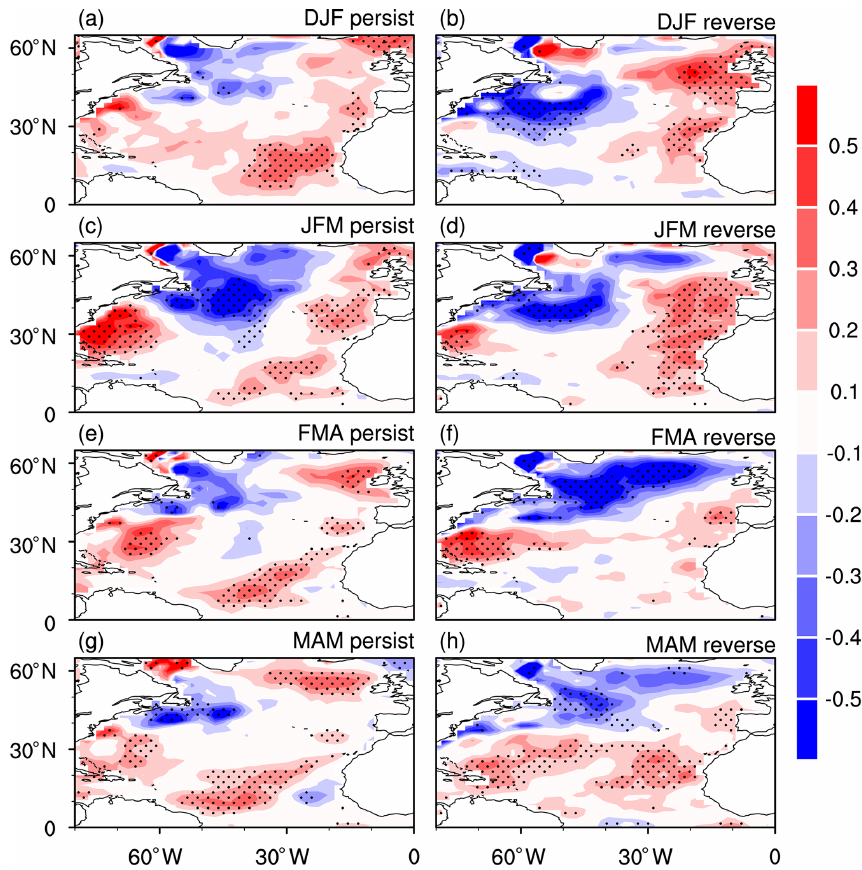
Figure 11. Composite anomalies of surface net heat fluxes (Wm − 2 ) in (a, b) DJF, (c, d) JFM, (e, f) FMA, and (g, h) MAM for (left column) the persistent years and (right column) the reverse years. Stippled regions in the figure indicate anomalies that are statistically significant at the 5%